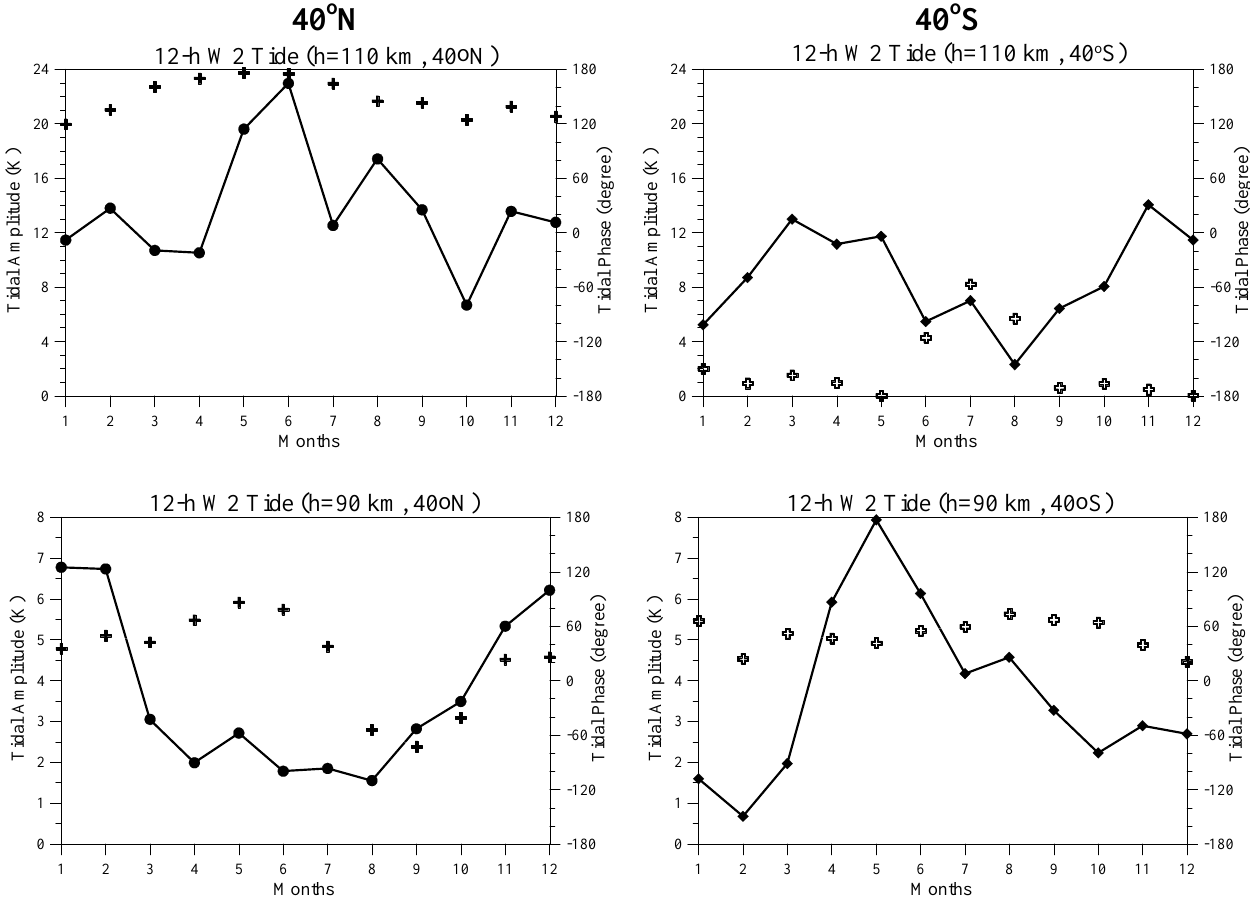
◦ N and with diamonds for 40 ◦ S) and Figure 4 Fig. 4. Average (2002–2007) seasonal behavior of the tidal amplitudes (solid line with dots for 40 phases (crests for 40 ◦ N and empty crests for 40 ◦ S) at altitudes: 110km (upper row of plots) and 90km (bottom row of plots); the results for the NH are shown in the left column of plots and for the SH – right column of